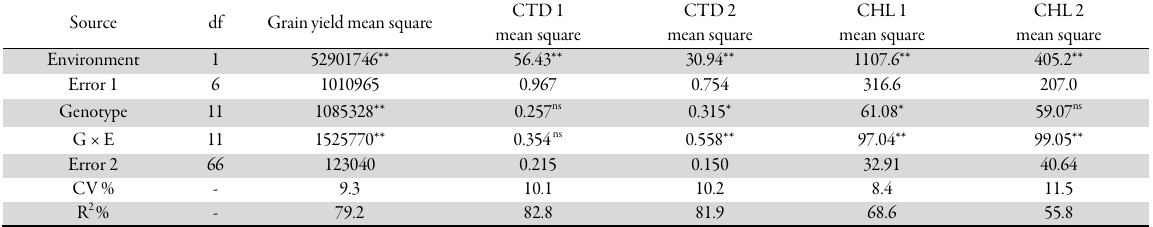
Table 3. Combined analysis of variance for grain yield, canopy temperature depression (CTD) and chlorophyll content (CHL) for both rain-fed and supplementary irrigation conditions Source df Grain yield mean square Environment